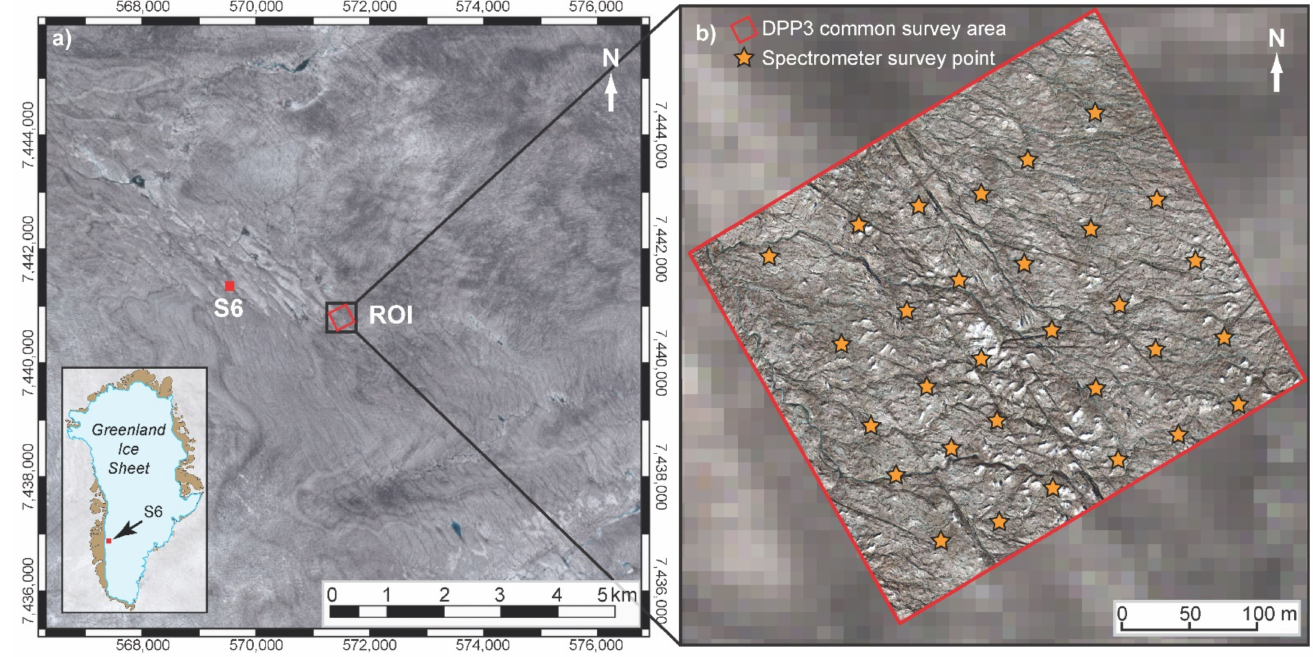
Figure 1. ( a ) Location of the ROI proximate to S6 (red dot) with Sentinel-2 imagery from 5 July 2016, to provide broader regional context and illustrate representativeness of the study site; ( b ) uncrewed aerial vehicle survey area on 23 July 2016, overlain on the Sentinel-2 imagery, and ground-based point locations of repeat spectrometer data